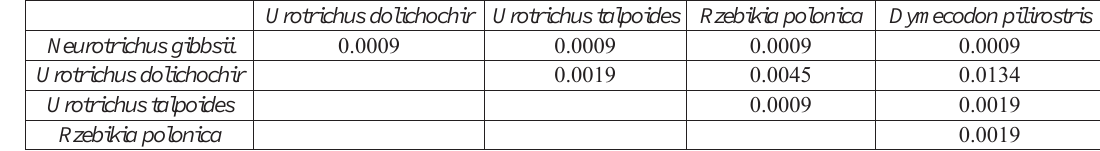
Table 1. Pairwise permuted MANOVA results. All p-values are corrected using “Holm” correction. Urotrichus dolichochir Urotrichus talpoides Rzebikia polonica